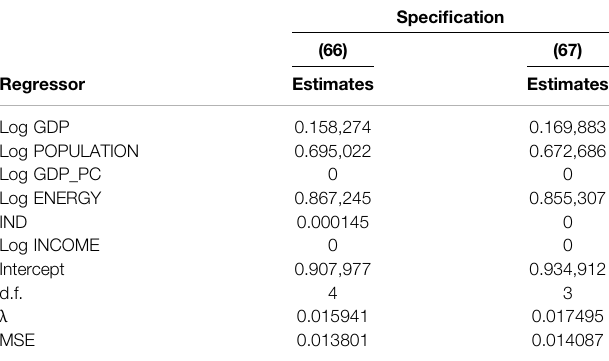
TABLE 5 | LASSO regression results for speci fi cation (66) and (67). TABLE 6 | LASSO regression results for speci fi cation (63) and